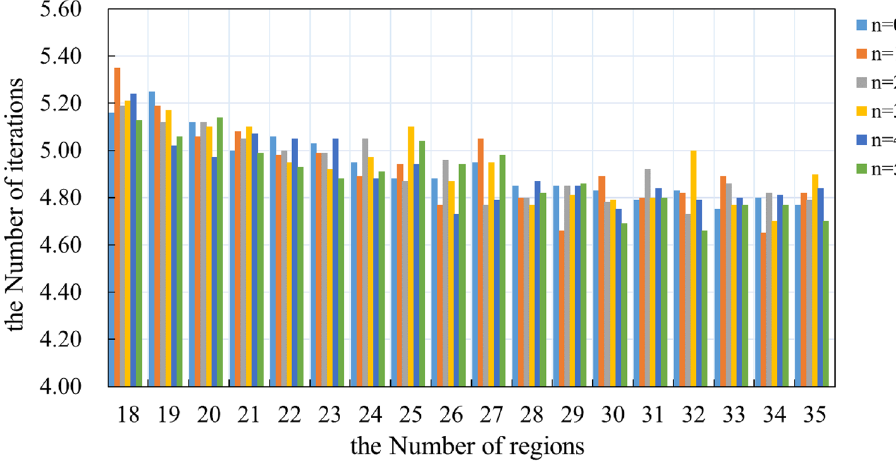
Fig. 11 Comparisons among different methods